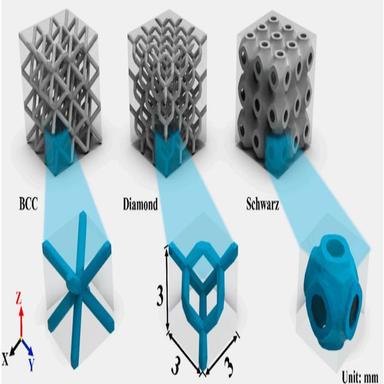
Three lattice structure models for LPBF process of 2024-5 vol% TiCN composite.